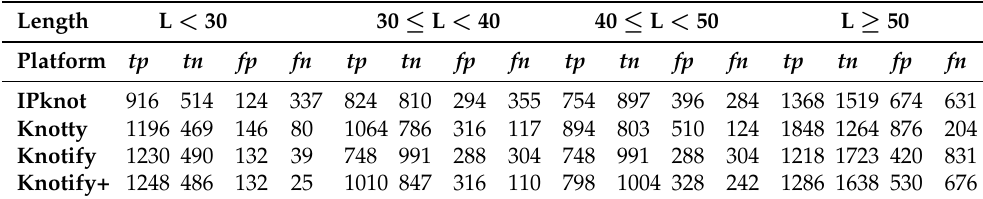
Table 4. The confusion matrices for each method per